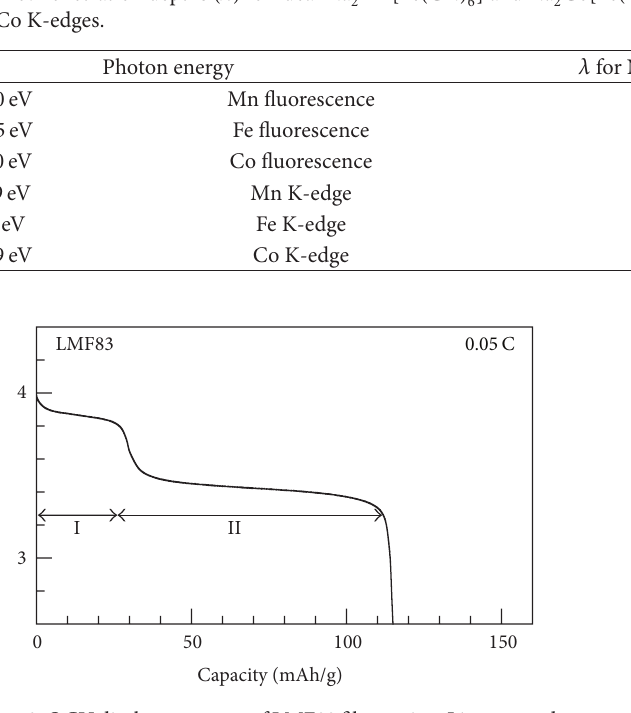
Figure 2: OCV discharge curves of LMF83 film against Li measured at 0.05C. For convenience of explanation, we define plateaus I and II (cited from [18]).